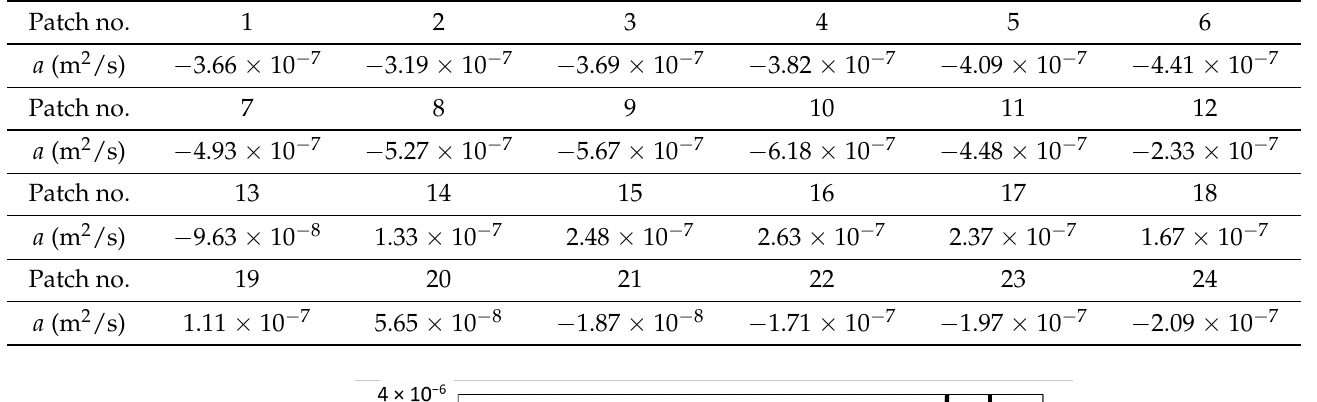
Table 2. Thermal diffusivity obtained for 3 February 2020.